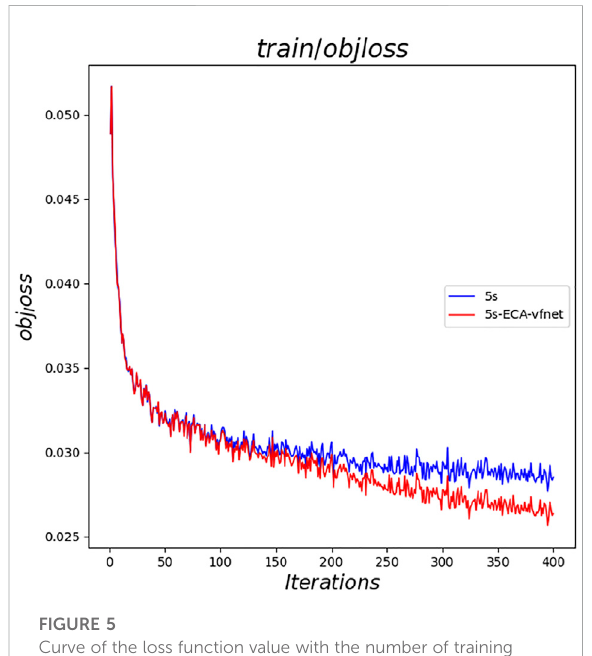
FIGURE 7 Comparison of boxloss.